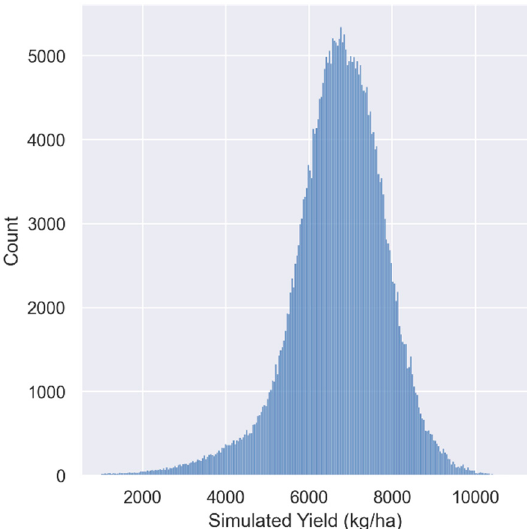
Figure 4. Histogram of Simulated Yields.